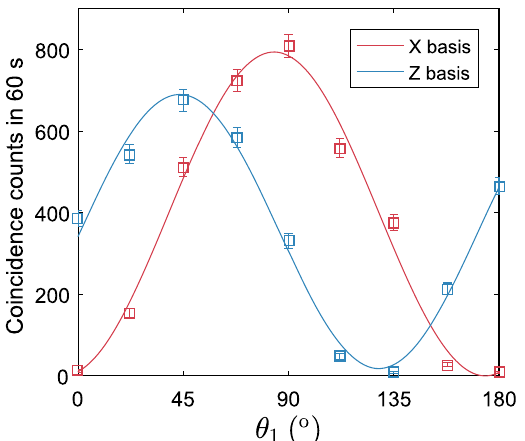
Fig. 8 Measured correlation curves for 100 GHz ITU channels 23 and 29. Squares correspond to experimental raw counts and solid lines to a fi t to a sine